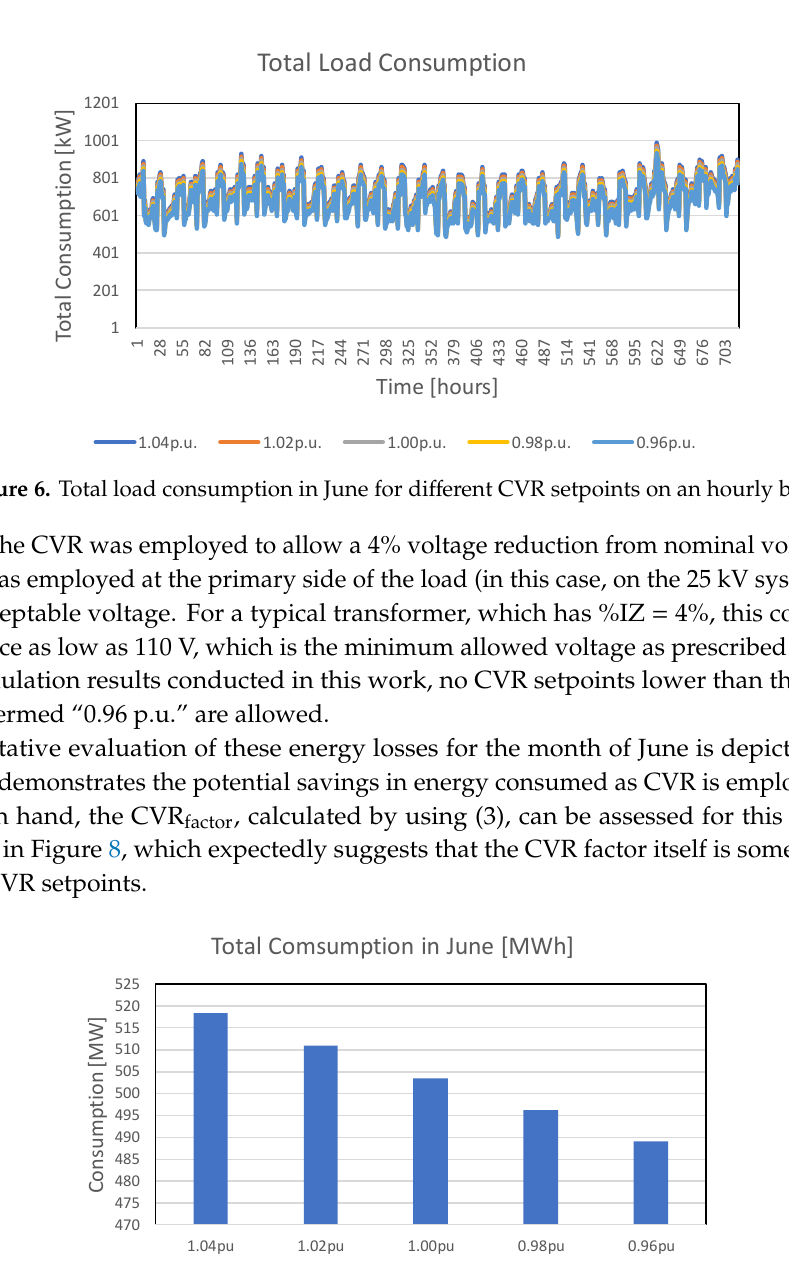
Figure 5. Total downstream losses in June for different conservation voltage reduction (CVR) setpoints on an hourly basis.